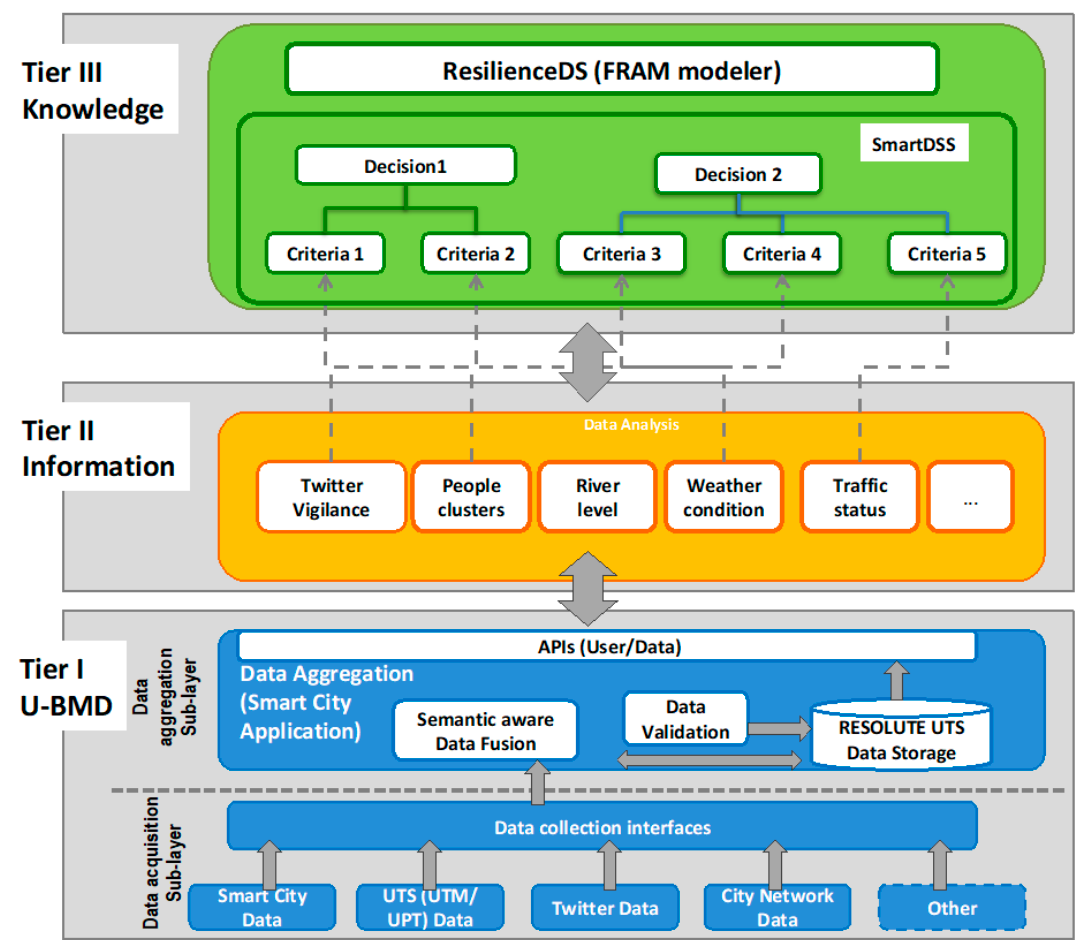
Figure 5. Three-tier RESOLUTE U-BMD Architecture. The architecture recalls the KID steps of data transformation for decision making presented in Figure